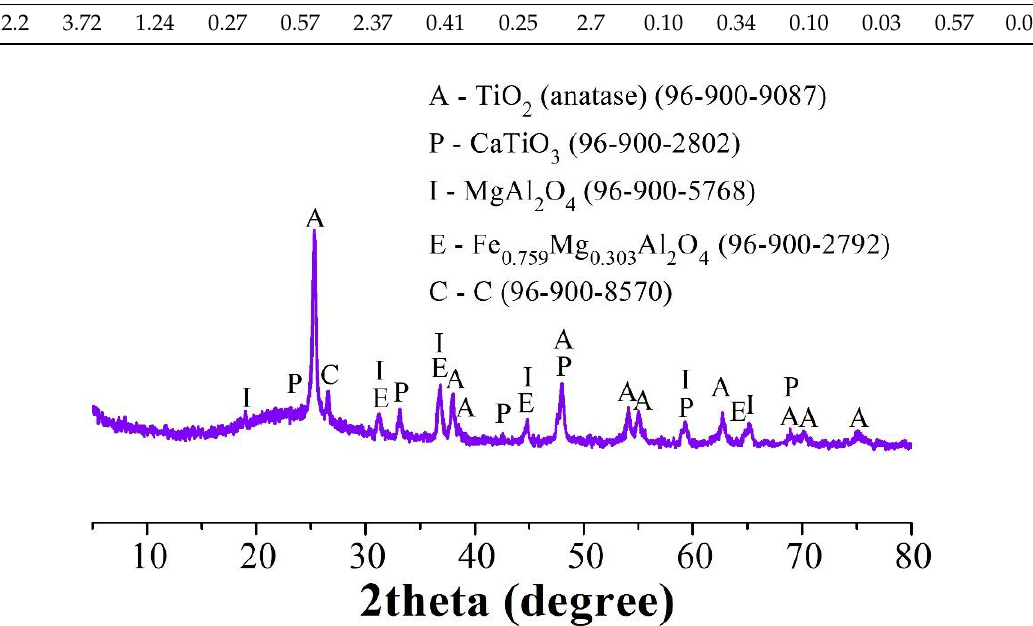
Figure 5. The XRD patterns of the accumulated residue after the high-pressure leaching of IDBR by 10% HCl at 210 °C at an L/S ratio of 11/1 for 15 min of the holding.